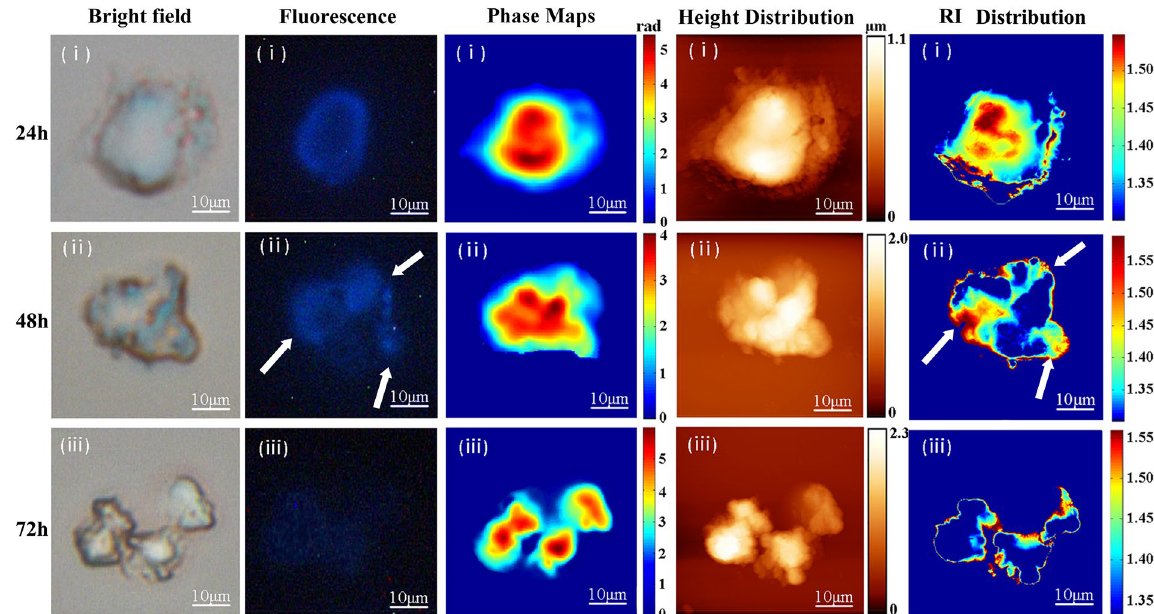
Figure 6. Experimental results of Jurkat cells treated with DNR in the ( i ) early stage; ( ii ) middle stage; ( iii ) late stage, in which the first column denoted the bright images of Jurkat cells, the second column were the fluorescence images of cellular nucleus stained with Hoechst 33258, the third column represented the cellular phase maps, the fourth column denoted the cellular height distribution, and the fifth column were the cellular refractive index